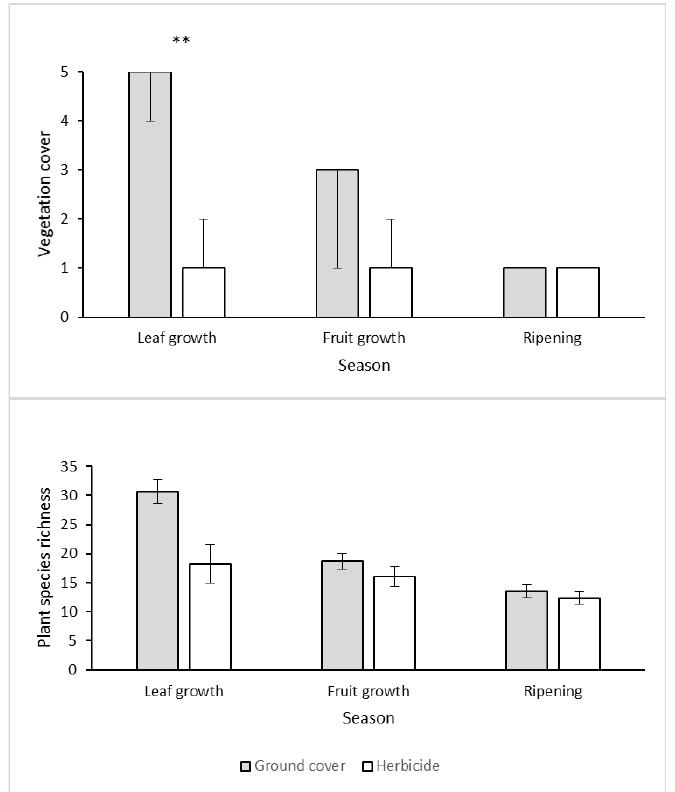
Figure 1. Top: Median vegetation cover scores (on a 1–5 scale) with their associated interquartile intervals, grouped by weed management treatment and season. Note that the 75% quartile line overlaps with the median in the ground cover treatment, while the 25% quartile line overlaps with the median in the herbicide treatment. Bottom: Mean ± SE plant species richness. ** Significant effect of treatment ( p < 0.01) in a post-hoc test.